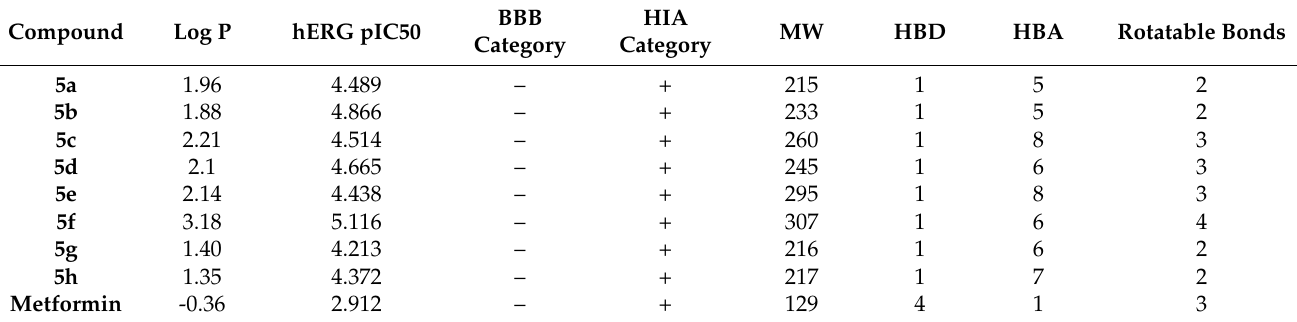
Table 2. Calculated pharmacokinetics of metformin